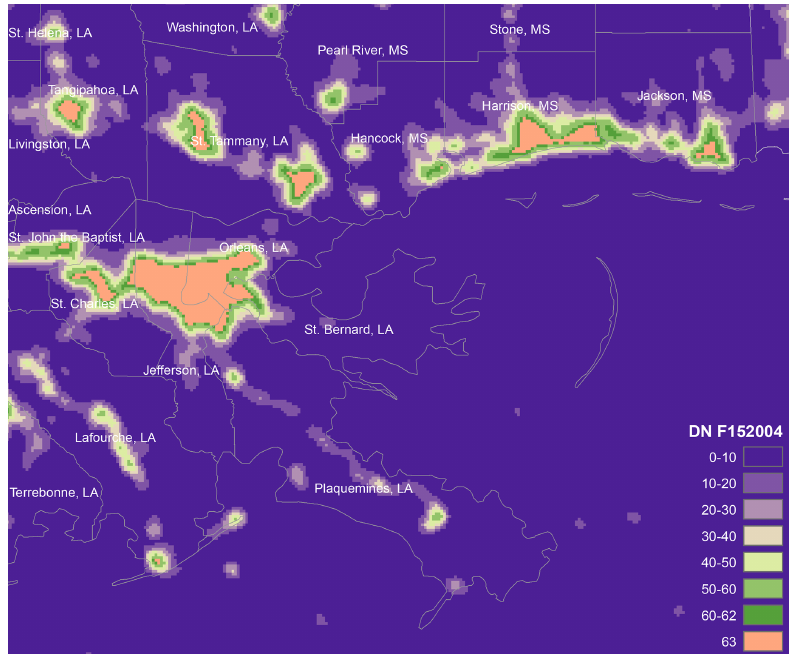
Figure 4. Night light intensity in the study region prior to Katrina, 2004. Based on own calculations using satellite F15, corrected with the Elvidge et al. (2014) calibration method. Top-coded pixels are indicated in orange. County names are in white.